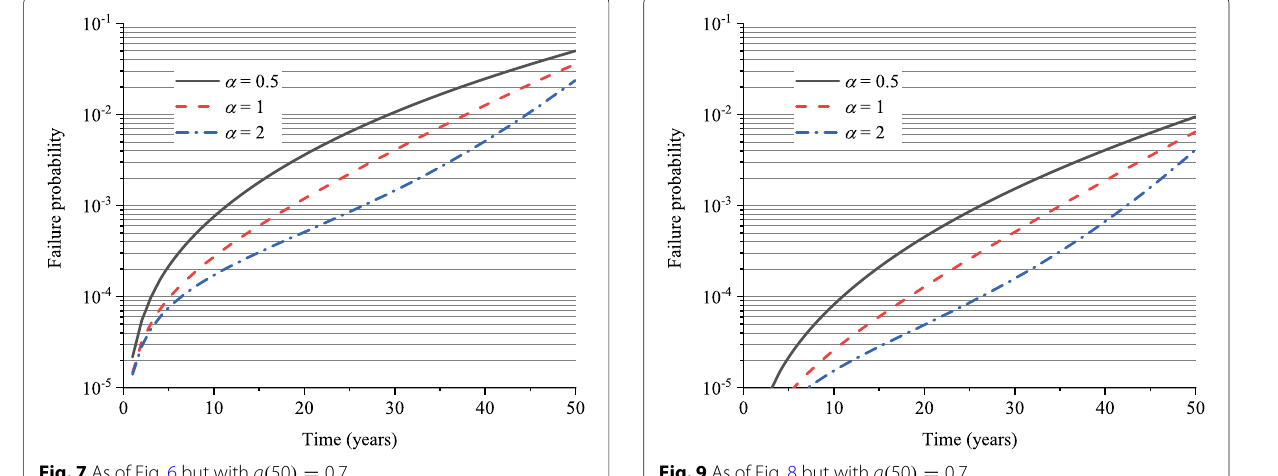
weighted in Fig. 11. A greater resistance correlation results in a greater failure probability due to the increased vari- ation of M ( R , 4 ) . In fact, as ρ increases from 0.3 to 0.9, the standard deviation of M ( R , 4 ) increases from 471.3 to 673.7 kN · m. While the mean of M ( R , 4 ) increases from